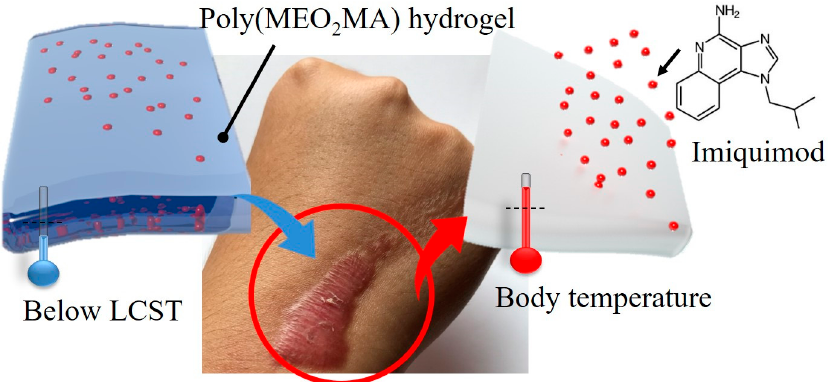
Figure 1. Schematic illustration of our purposed imiquimod-poly(MEO 2 MA) hydrogel-based treatment for keloid therapy. LCST: lower critical solution temperature.